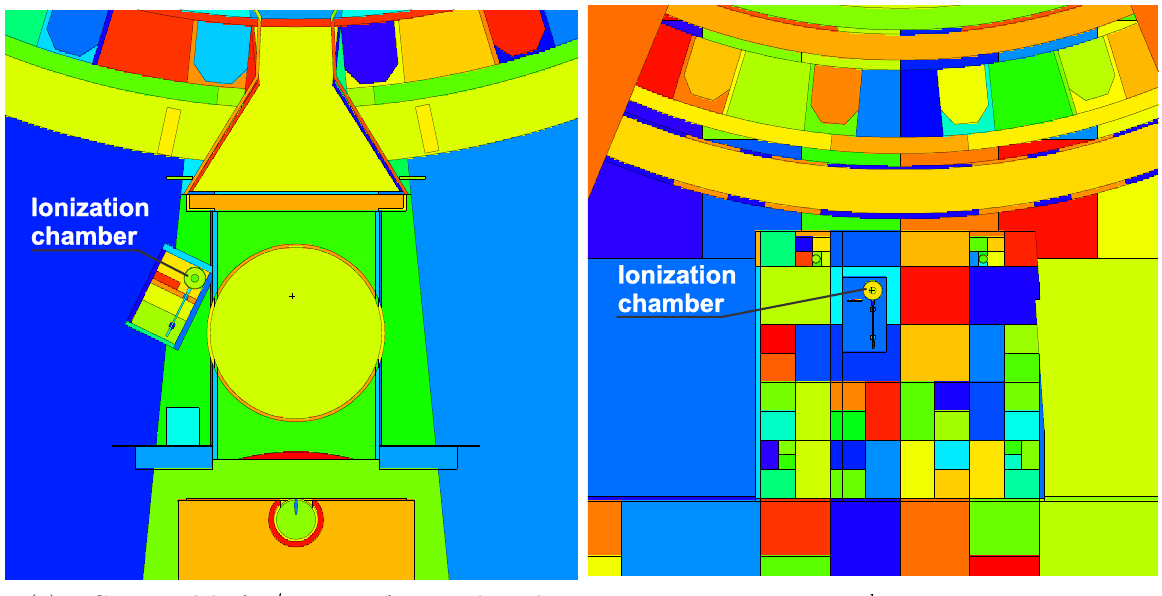
Figure 3: MCNP octant model of JET tokamak with highlighted ionization chambers for tallying, corresponding to actual